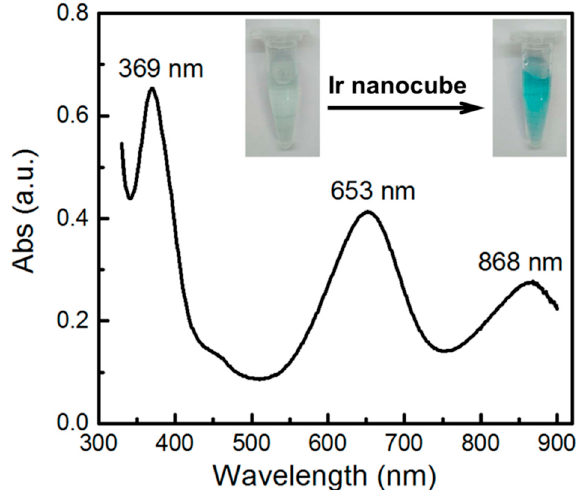
Figure 2. ( a ) TEM of a typical Ir nanoparticle. ( b ) SAED of the nanoparticle. ( c ) XRD of the nanoparticles as synthesized on Cu foil.